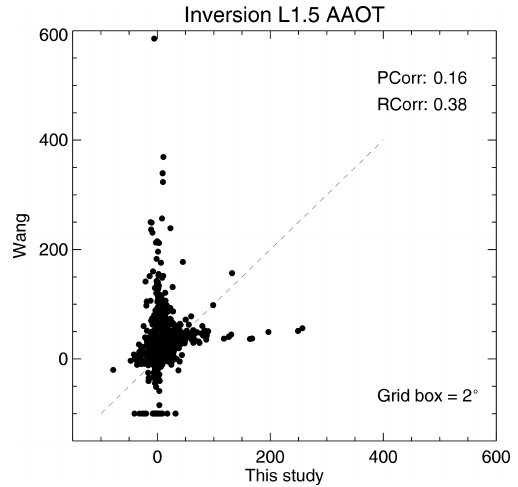
Figure 15. Comparison of yearly representation errors for AAOT from AERONET inversion L1.5 as estimated in this paper or us- ing the methodology from Wang et al. (2018) and a model grid-box size of 2 ◦ . The representation error shown is the spatial represen- tation error (Schutgens et al., 2017); i.e. temporal sampling of ob- servations is ignored. Also shown are the Pearson linear correlation (PCorr) and rank correlation (RCorr) between the data. The dashed line shows y = x